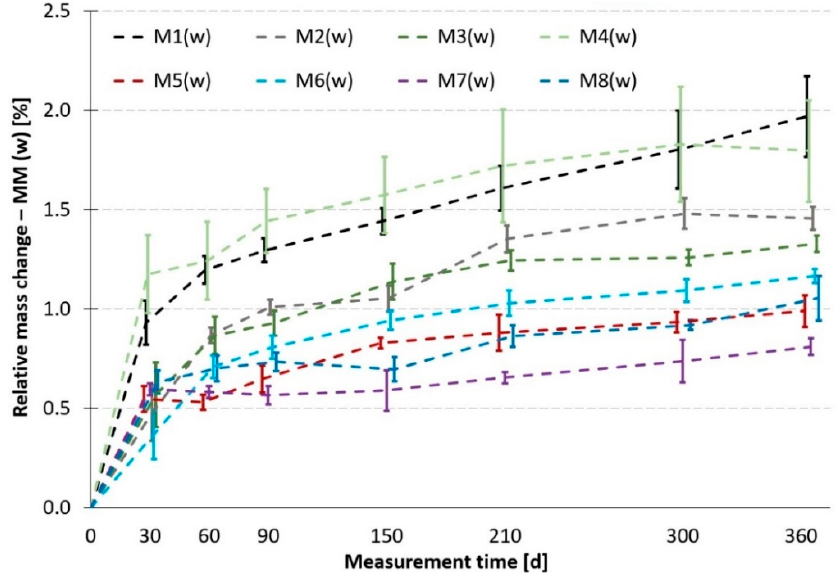
Figure 10. Dependence of the relative mass change on the immersion time of the samples in the water